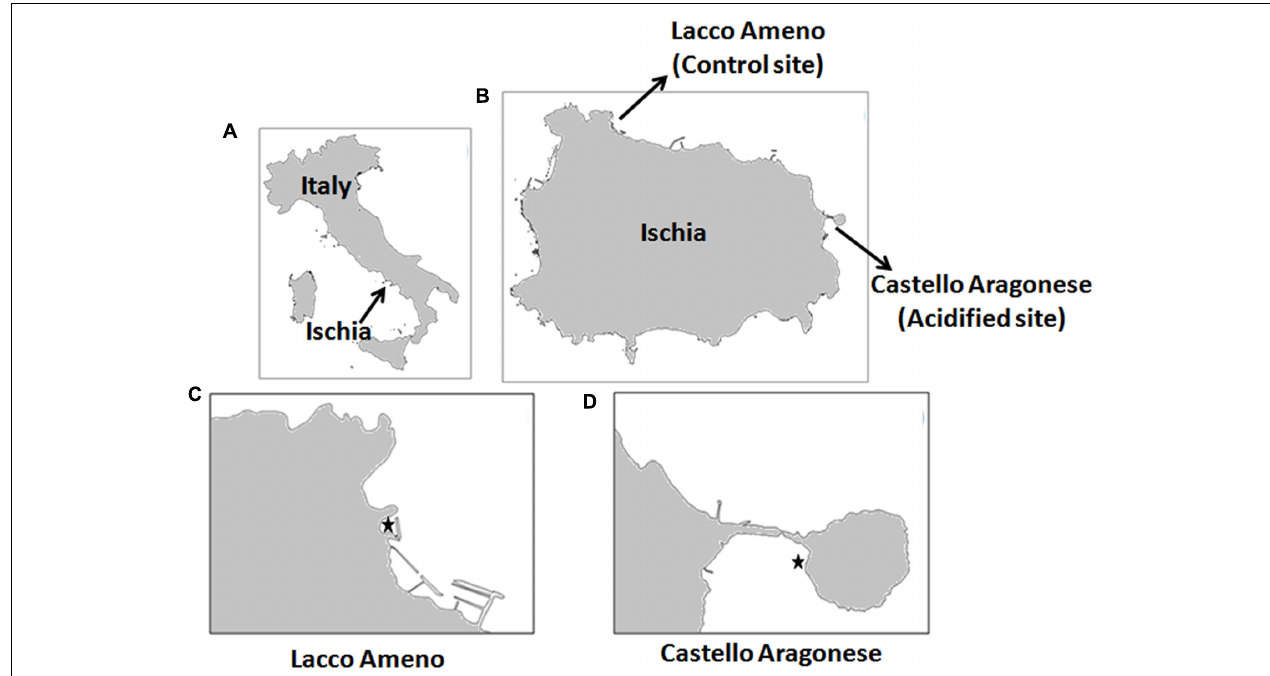
FIGURE 1 | Study sites. (A) Map of Italy; (B) map of Ischia Island showing the location of Lacco Ameno and Castello Aragonese sites; (C) close up view of the control site Lacco Ameno; (D) close up view of the acidified site Castello Aragonese. In (C,D) , marked point showing locations of Sargassum vulgare (Image generated through qGIS v.